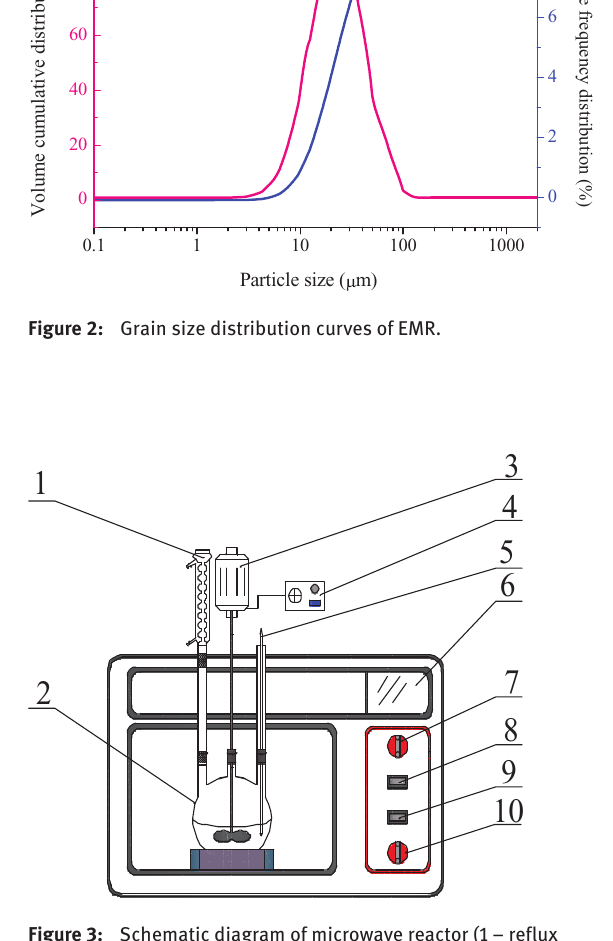
Figure 3: Schematic diagram of microwave reactor (1 – reflux